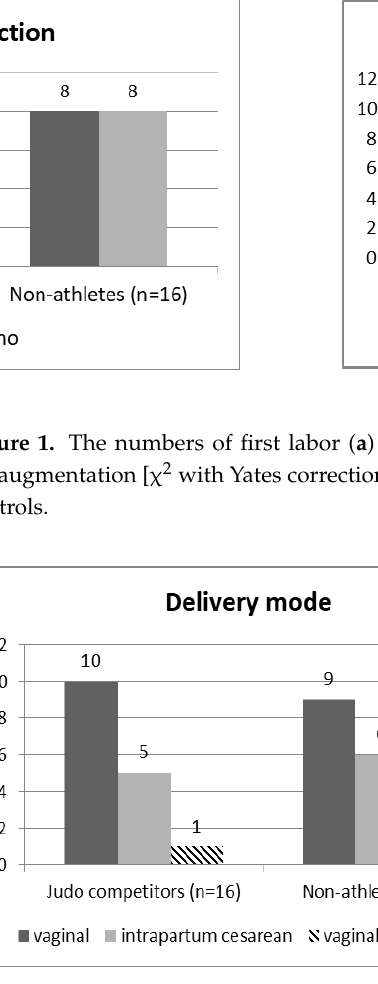
Figure 2. The numbers of vaginal, intrapartum cesarean, and vacuum-assisted vaginal deliveries in elite judo athletes and non-athlete controls [ χ 2 (2) = 0.14, p = 0.93]. Table 4. Duration of labor and the neonate’s Apgar score in elite judo athletes and non-athletes with vaginal deliveries *.